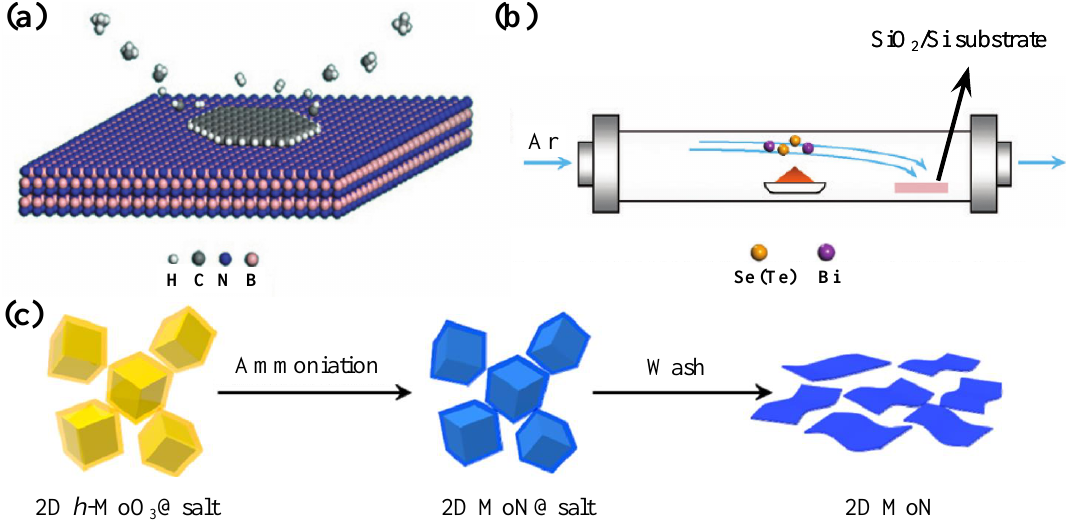
Figure 7. The preparation of 2D materials based on MBE, VS, and template methods. ( a ) Schematic of graphene fabricated by epitaxial growth. Adapted with permission from [164]. Copyright 2013 Macmillan Publishers Limited. ( b ) Schematic of Bi 2 Se 3 and Bi 2 Te 3 fabricated by VS growth. Adapted with permission from [165]. Copyright 2010 American Chemical Society. ( c ) Schematic of 2D MoN fabricated by template method. Adapted with permission from [166]. Copyright 2017 American Chemical